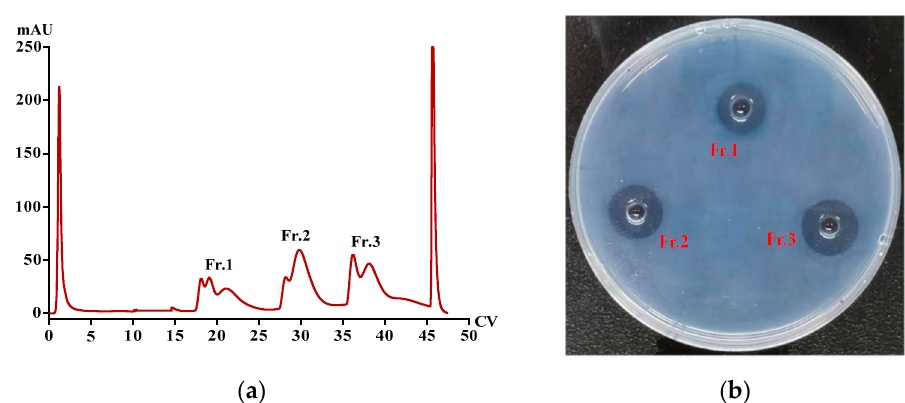
Figure 6. ( a ) HiTrap Q HP-chromatographic pattern. The bound proteins were eluted from 0 to 20 mM NaCl solution. ( b ) The fibrinolytic activity of three fractions.